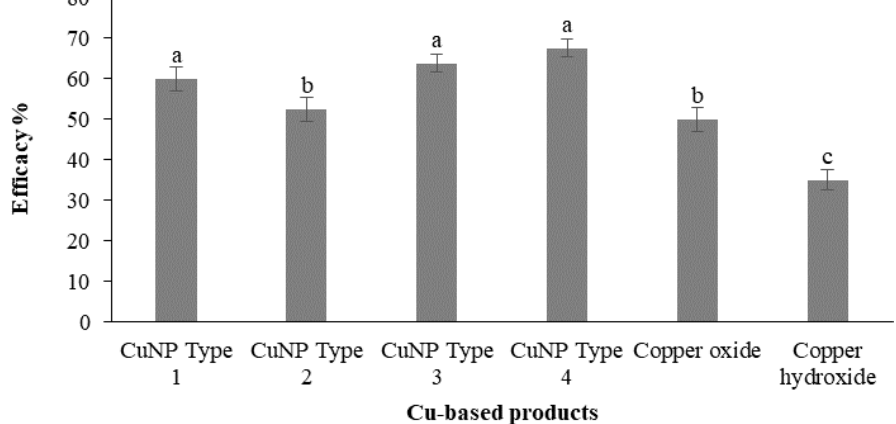
Figure 8. Efficacy (%) of Cu-NPs and conventional Cu-product treatments against Fusicladium oleagineum in experiments conducted in one-year-old olive trees (cv. Chalkidikis) incubated in a plant growth chamber. Treatments’ efficacy (%) assessments were based on the disease incidence measurements on the untreated control plants. Different letters on the columns indicate significant differences according to Fisher’s LSD test at p = 0.05. Vertical lines indicate the standard error of the mean.